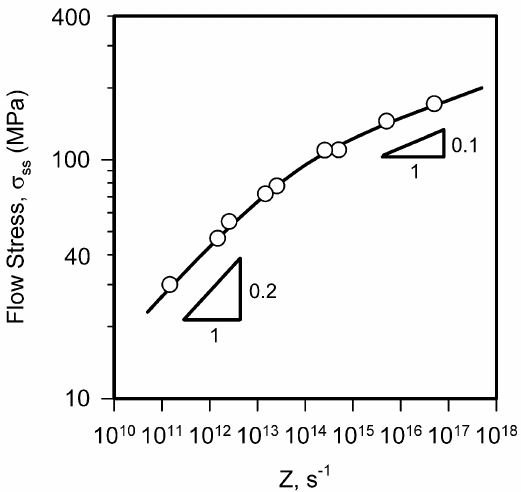
Figure 3. Steady-state flow stress vs. temperature-compensated strain rate ( Z ) for the hot compression of a high-Mn steel.